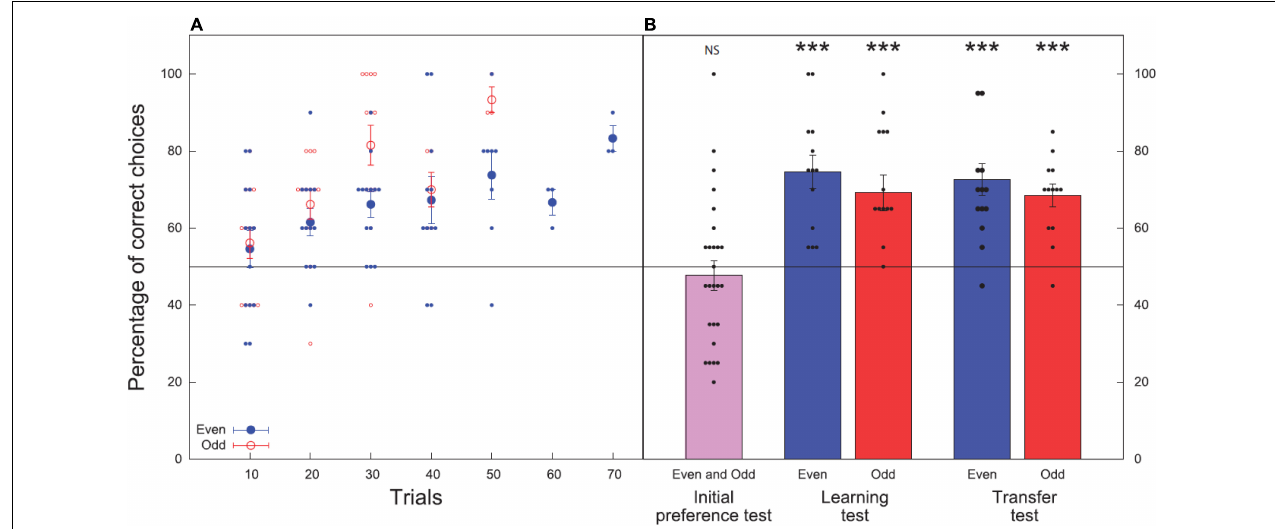
FIGURE 4 | Bee performance during the learning and test phases: initial preference test, learning test, and transfer test. Data shown are means ± standard error of the mean (SEM) for both treatment groups (even; odd). N = 13 bees were used in each group for each test, 26 bees were tested overall. Black line at 50% indicates the chance level performance. (A) Results of the learning phase (before reaching criterion). Closed blue circles show bees trained to even numbers while open red circles show results for bees trained to choose odd numbers. Larger circles show the mean ± SEM and smaller circles show the individual results of each bee. (B) Results of the preference, learning, and transfer tests for the respective groups (even; odd). Initial preference test shows the results of all 26 bees for their initial preference (before training) for even element numbers. Black circles show the individual results of each bee for all tests. Significance from chance level performance is indicated by NS > 0.05, *** ≥ 0.001. There was no significant difference between the learning and transfer